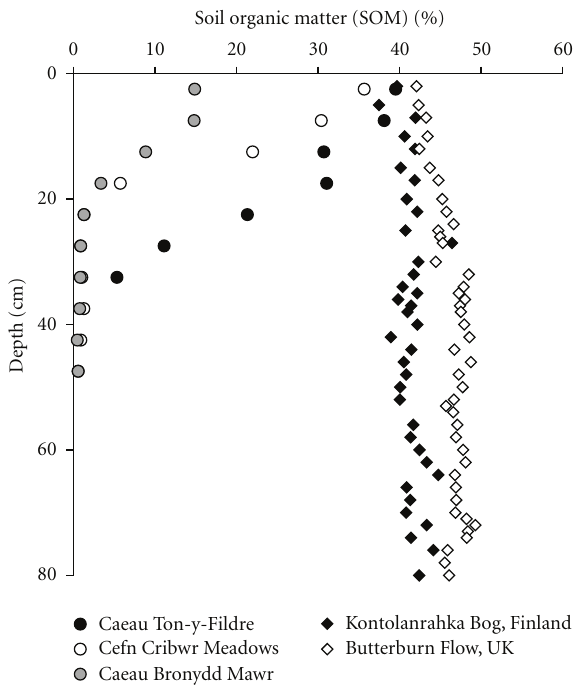
Figure 4: Soil organic matter (SOM) content at soil sites (dots): Caeau Ton-y-Fildre (black), Cefn Cribwr Meadows (white), Caeau Bronydd Mawr (grey); compared to peat sites [24] (diamonds): Kontolanrahka Bog, Finland (black), Butterburn Flow, UK